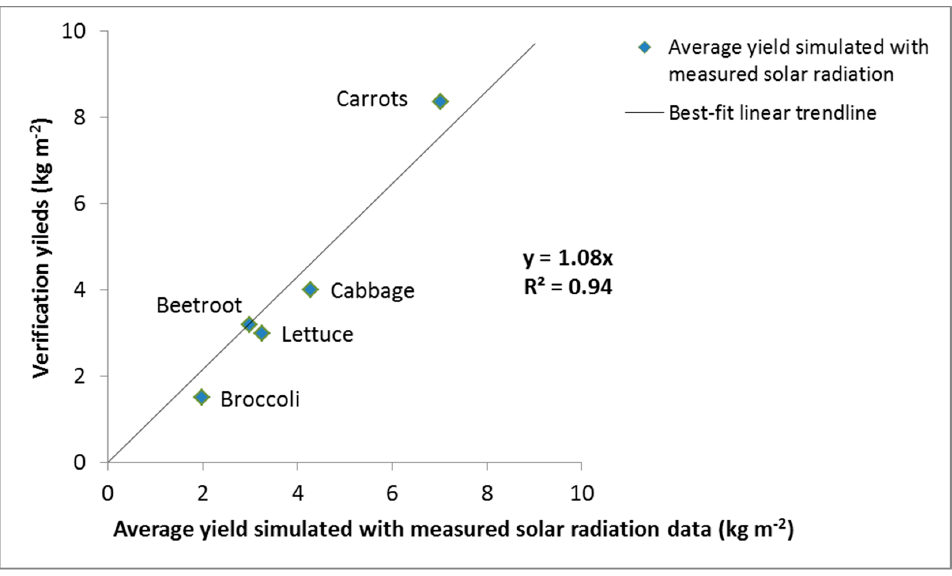
Figure 3. Correlation between verification yield data and yields simulated with the Soil Water Balance model using measured solar radiation data for carrots, cabbage, beetroot, broccoli and lettuce grown in summer.